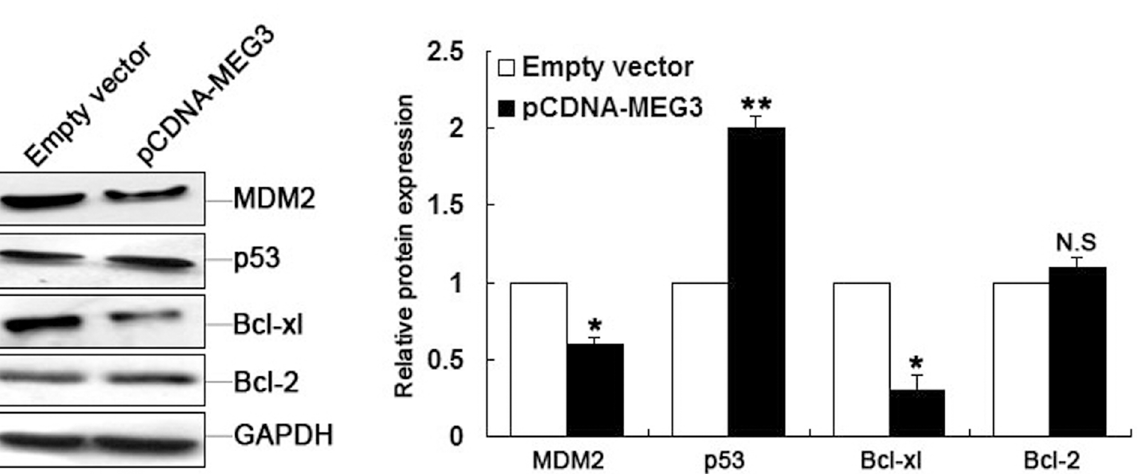
Fig 6. MEG3 induces the activation of p53 and Bcl-xl proteins. Western blot analysis of MDM2, p53, Bcl-xl, and Bcl-2 expression levels after pCDNA- MEG3 or empty vector transfection. * P < 0.05, ** P < 0.01.